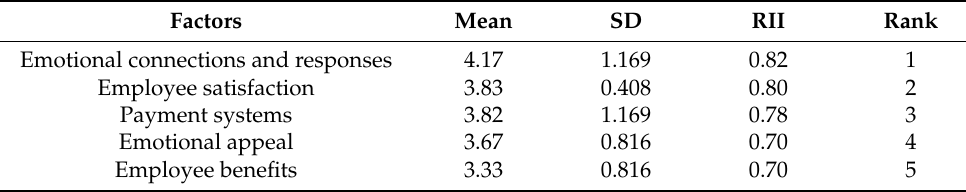
Table 7. Classification under